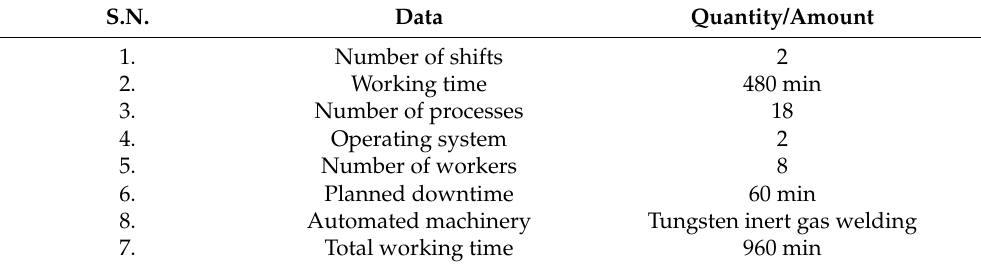
Table 1. Observed data from the shop